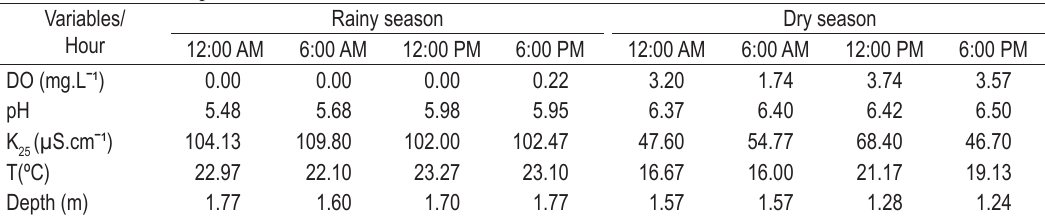
Table 2. Abiotic factors measured on Salvinia auriculata stands in Cavalos Lake in different hours of the nycthemeral cycle during rainy and dry seasons (DO – dissolved oxygen; K25 – electrical conductivity corrected to 25 °C; T – surface water